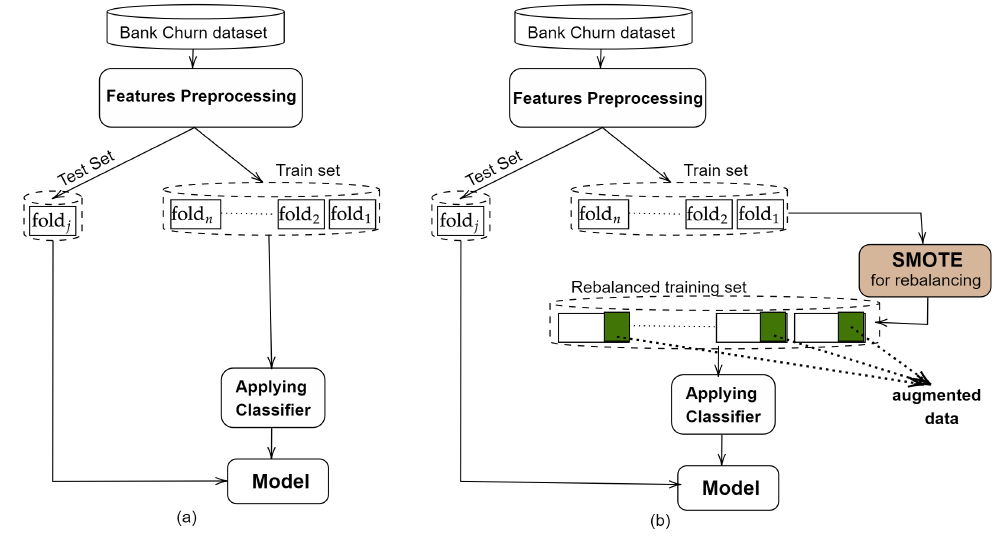
Figure 5. Illustration of the experimental protocol ( a ) without and ( b ) with data